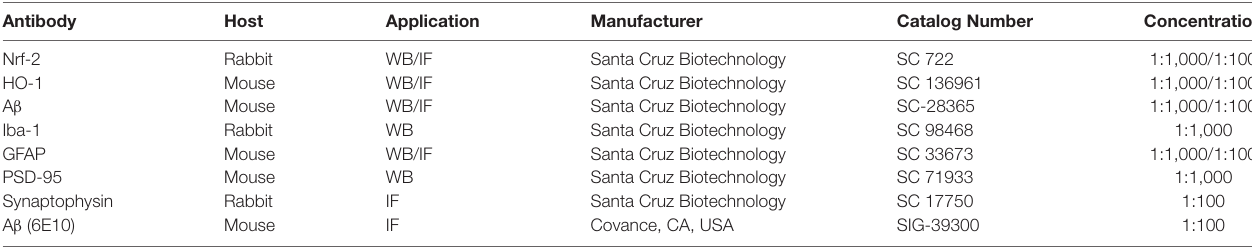
TABLE 1 | The list of primary antibodies and their detailed information.